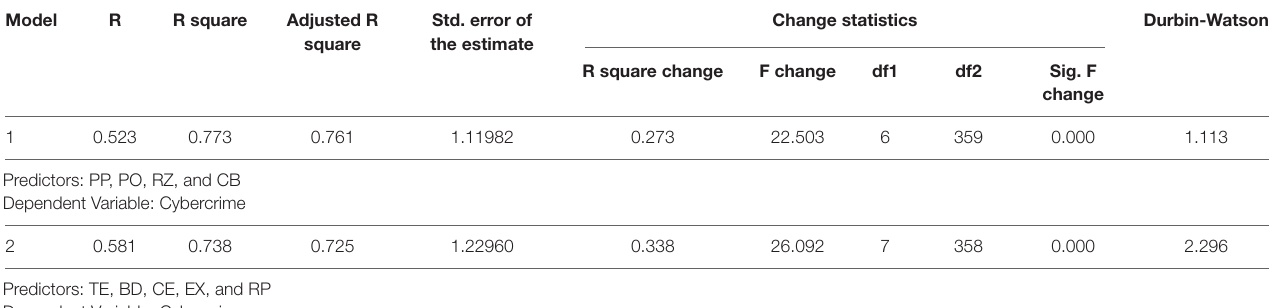
TABLE 4 | Regression dependent variable (cybercrime and risk